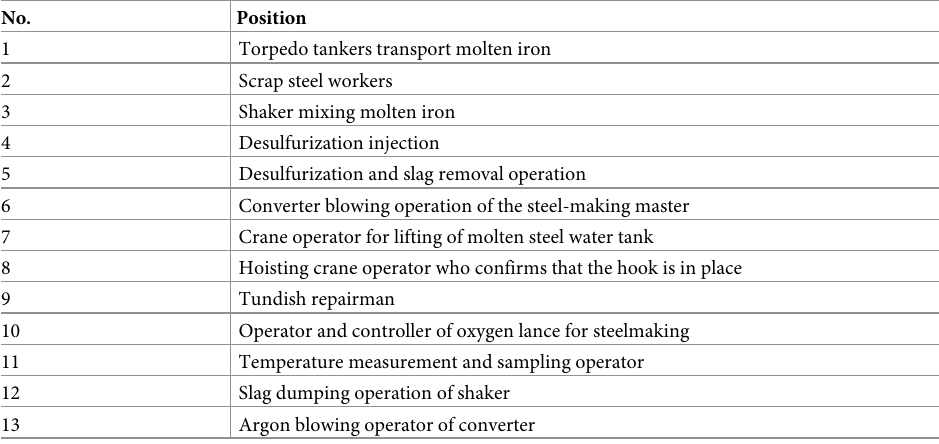
Table 4. Ranks, human erroneous operations, and cause accidents at different positions.